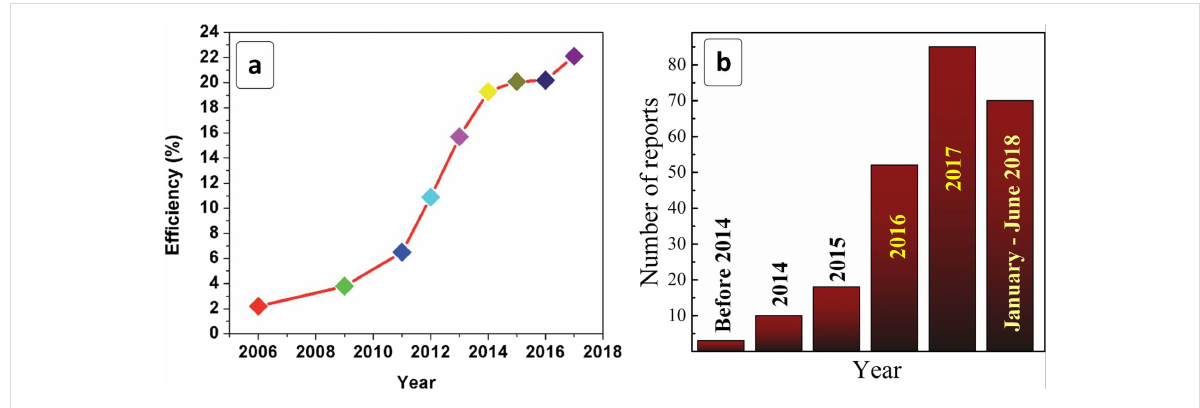
Figure 1: Temporal evolution of (a) the power conversion efficiency of lead-HP-based solar cells and (b) the number of publications on lead-free HPs. (a) Reprinted with permission from [27], copyright 2018 The Royal Society of Chemistry.